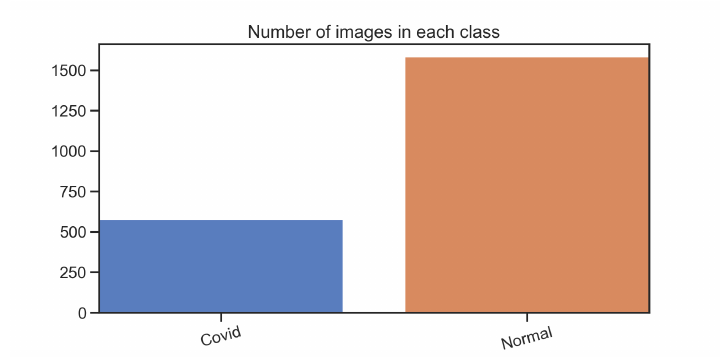
Figure 2. The proportion of each class’s data in the data set 2.